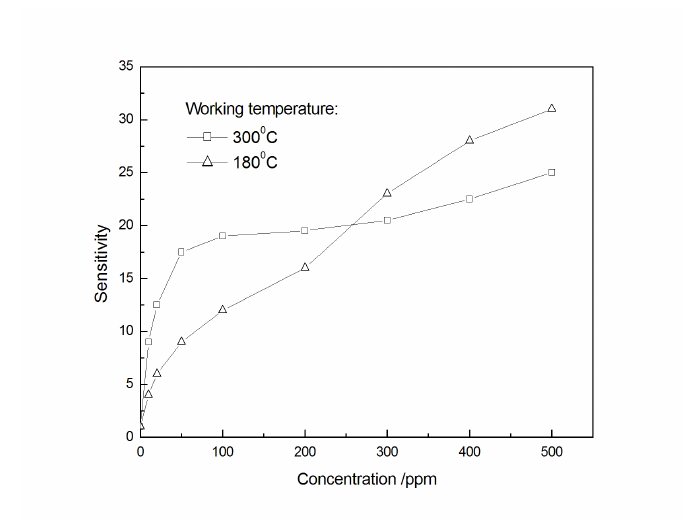
Figure 5 . Sensing properties of ITO thin